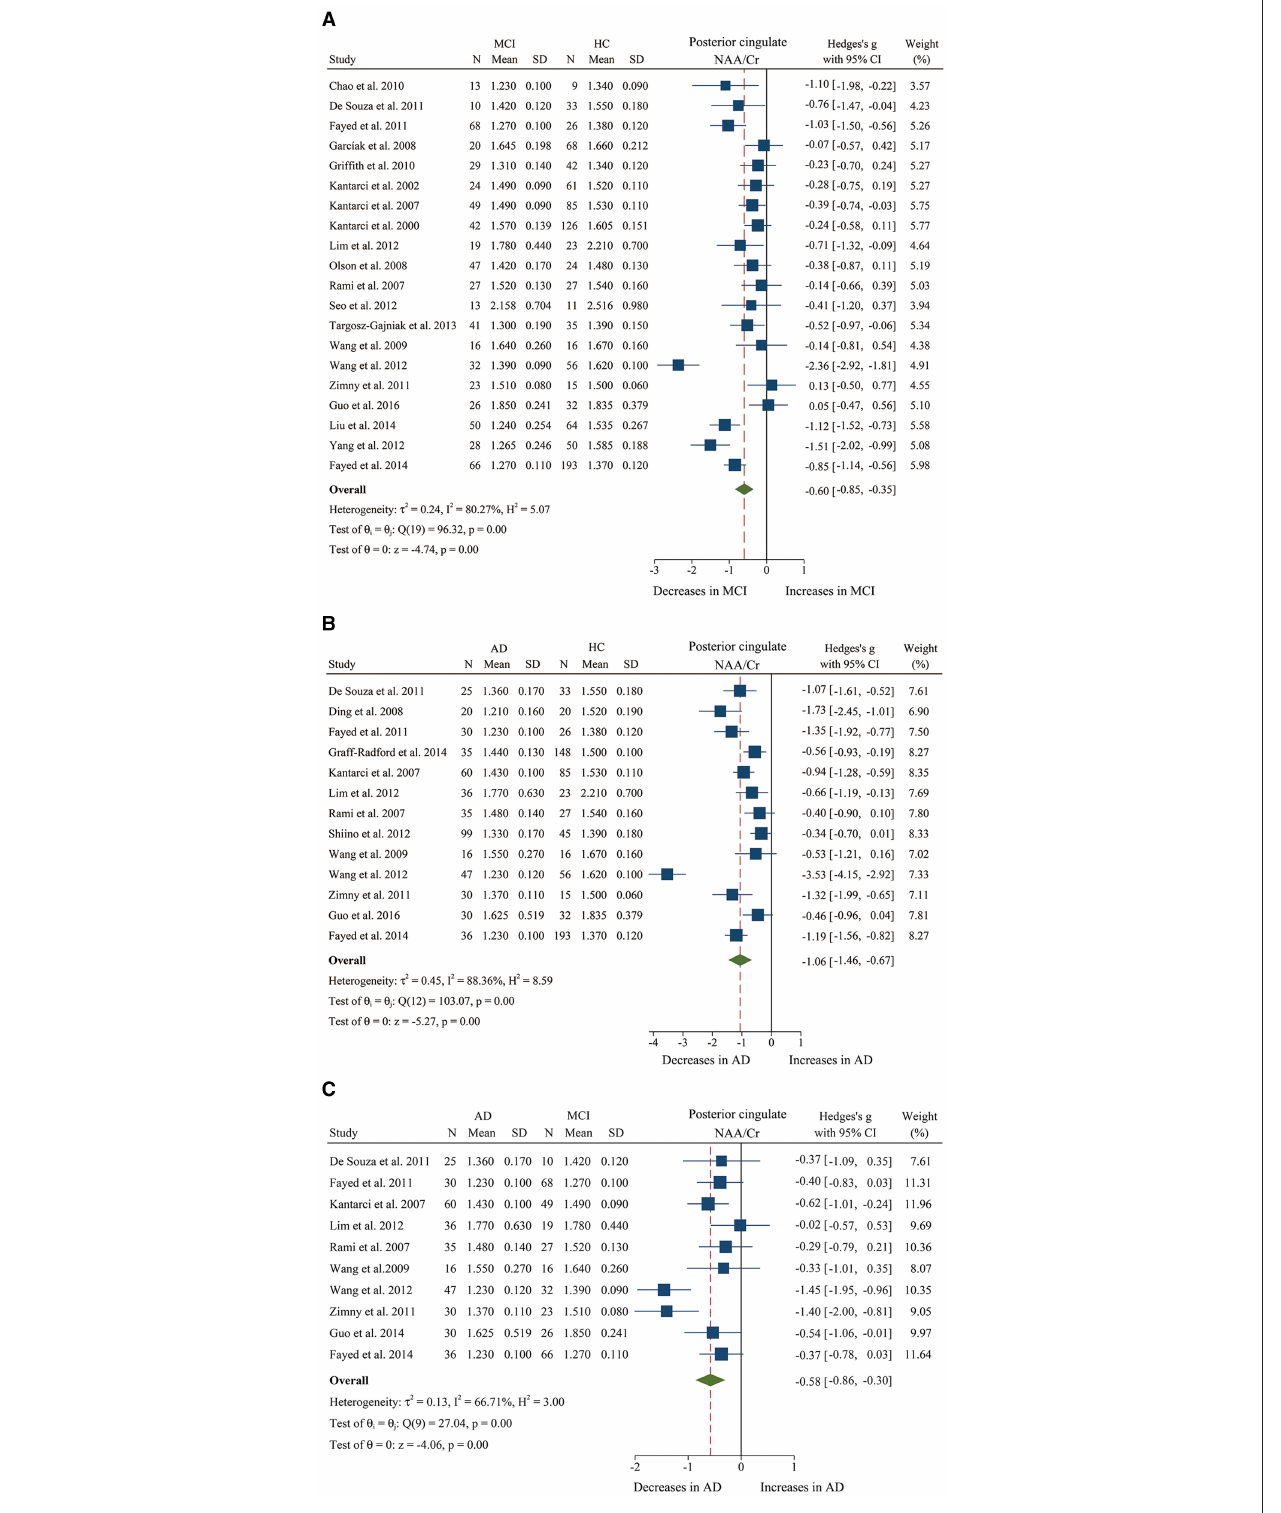
FIGURE 3 | Forest plots show the change of the ratio of NAA/Cr in the posterior cingulate between MCI, AD patients, and HC subjects. (A) Data include 1639 individuals from 20 studies for meta-analysis of NAA/Cr levels between MCI and HC. (B) Data include 1218 individuals from 13 studies for meta-analysis of NAA/Cr levels between AD and HC. (C) Data include 681 individuals from 5 studies for meta-analysis of NAA/Cr levels between AD and MCI.